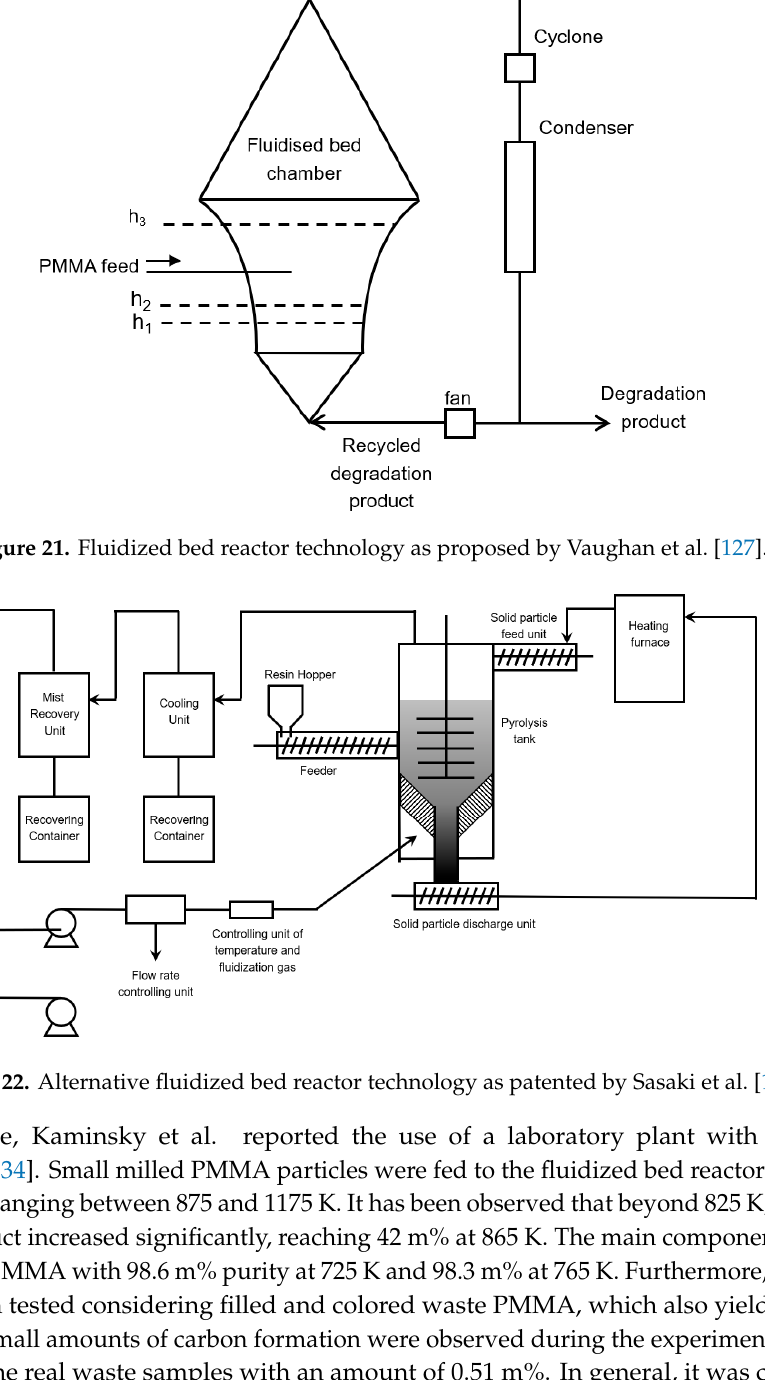
Figure 22. Alternative fluidized bed reactor technology as patented by Sasaki et al. [132] .